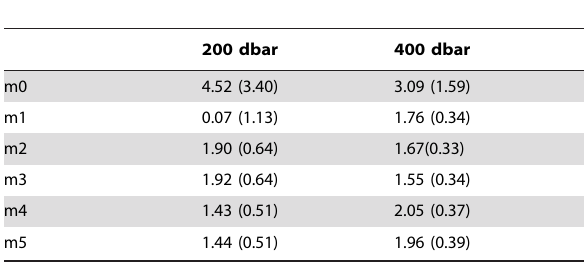
Table 4. Mean differences between the anthropogenic component of the 2009–2010 data and their counterparts predicted by extrapolating the accumulation rates inferred from the first 4